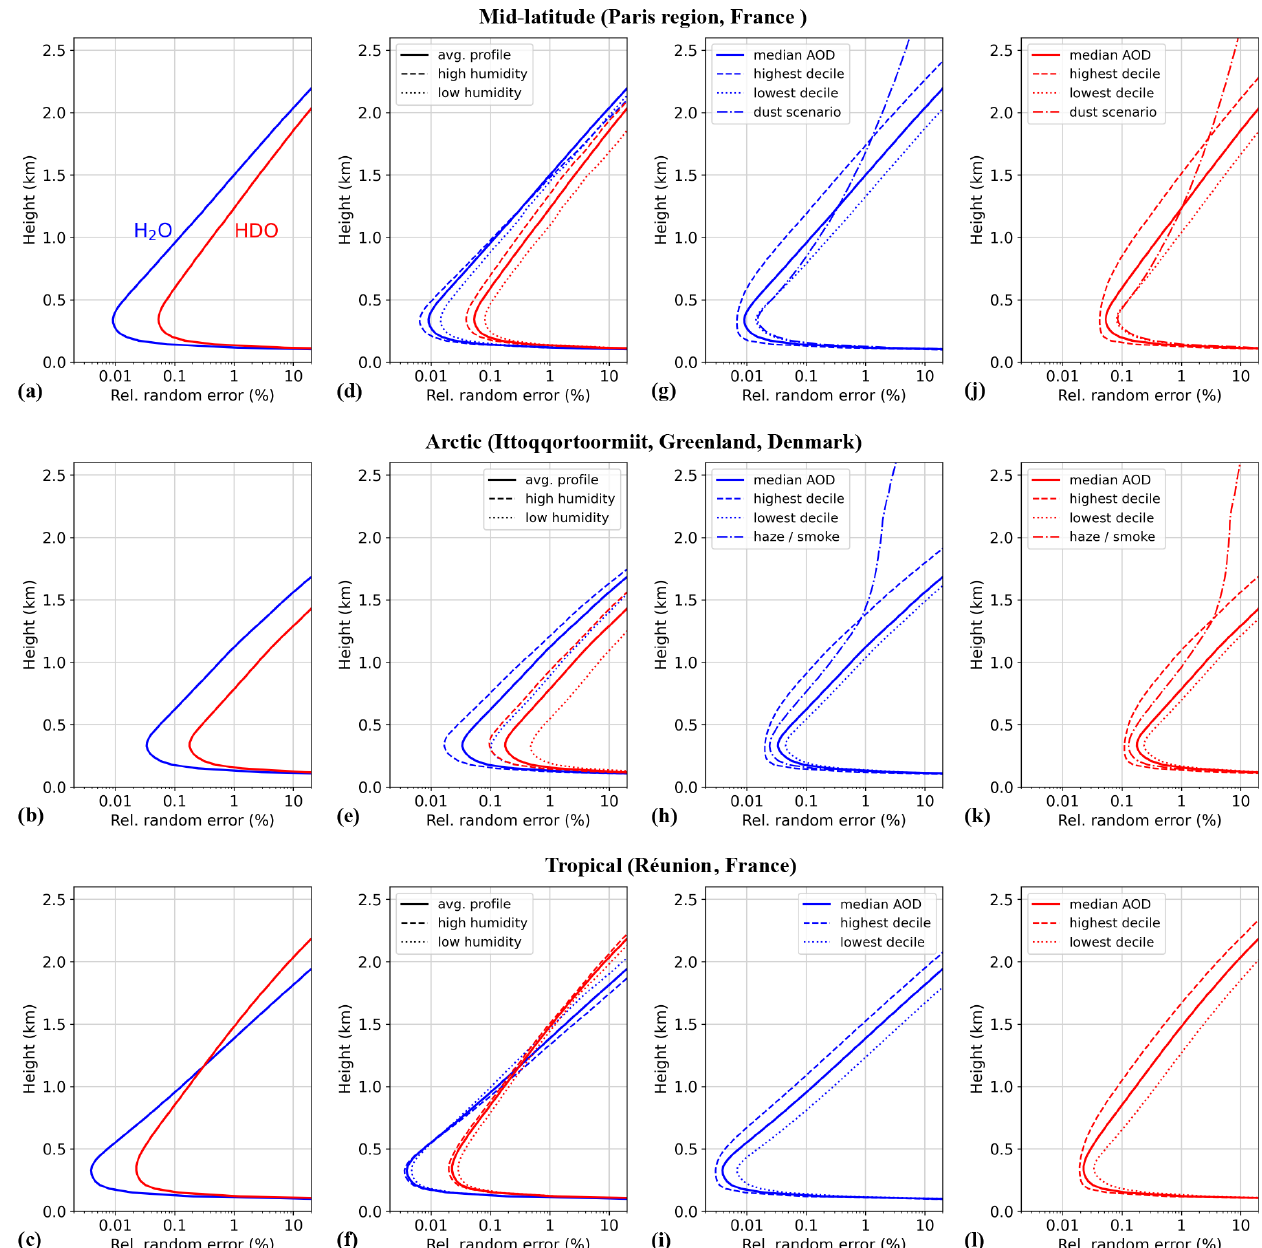
Figure 6. Sensitivity with respect to variability in atmospheric parameters: resulting statistical uncertainty for range-resolved DIAL mea- surement of H 2 O (blue, option 1 at 1982.93nm) and HDO (red, option 2 at 1983.93nm). Simulation parameters: 20mJ pulse energy, 1MHz bandwidth, 10min integration time, InGaAs PIN detector. (a–c) Reference model based on average columns of pressure, temperature and humidity. Aerosol baseline profile using median AOD assumed. (d–f) Sensitivity to water vapor variability. (g–i) Sensitivity to different aerosol profiles (H 2 O). (j–l) Sensitivity to different aerosol profiles